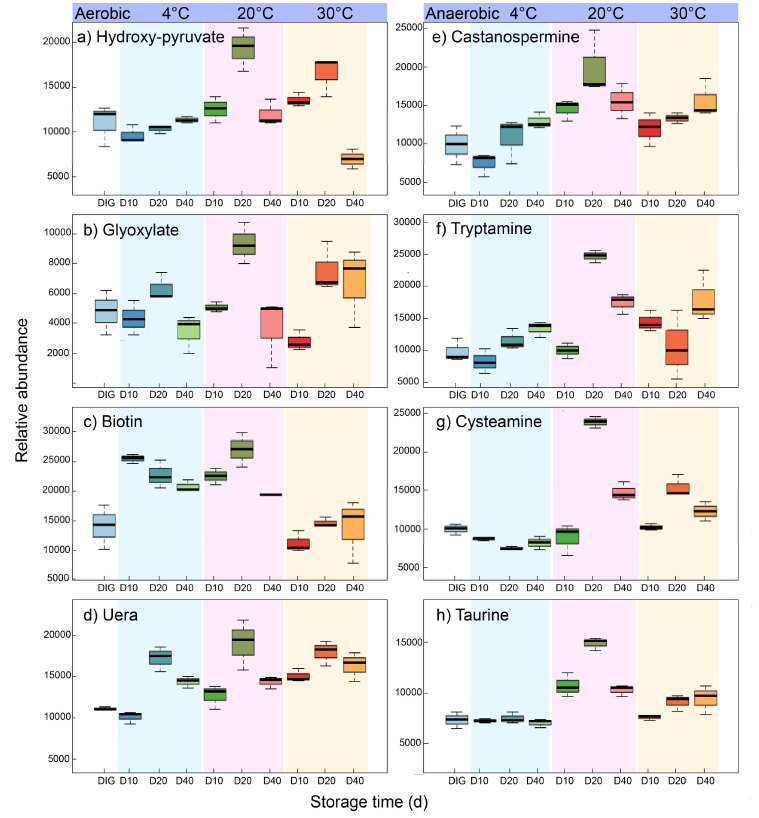
Figure 4. Box plots of the relative abundance of peak areas, representing the change tendency of eight bioactive compounds in the digestate under different storage modes. The a-axis represents the days of storage, and the y-axis represents the relative abundance of the bioactive compounds